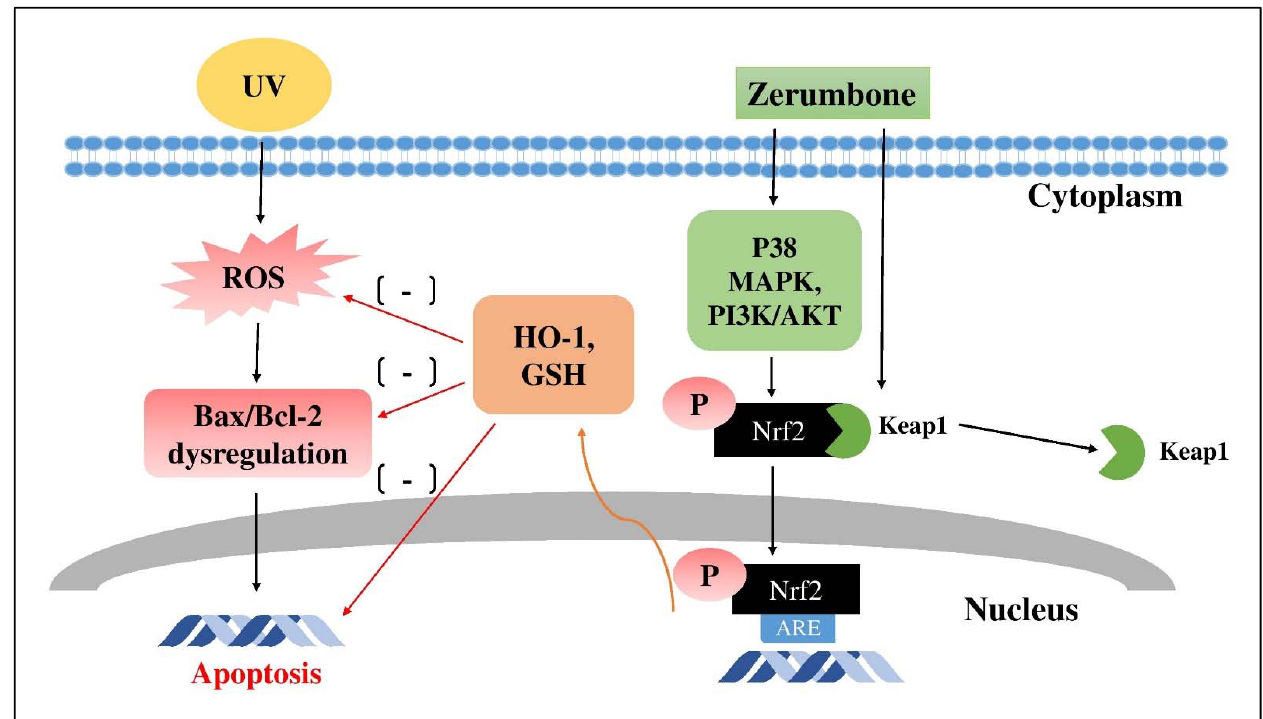
Figure 5. Mechanism of Nrf2 activation by ZB. The diagram was adapted and modified from Yang, H.-L. et al., 2018 [86].